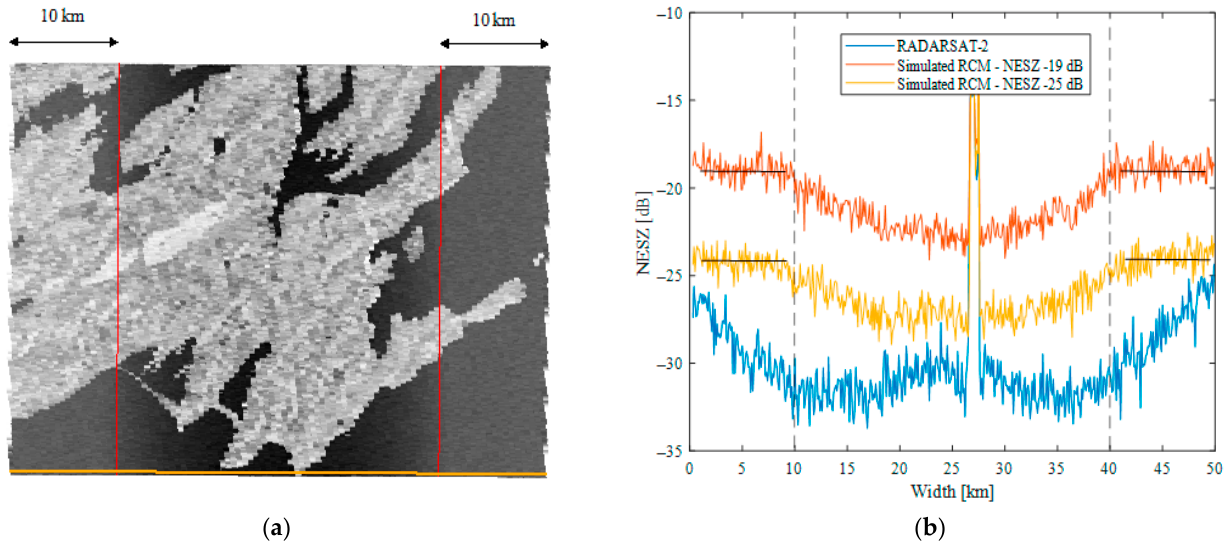
Figure 4. ( a ) Left: the initial extent of the simulated RCM data in the HV polarization, generated from the original RADARSAT-2 FQ17W mode over the Bay of Quinte, where red vertical lines show the 10 km strips at each side of the image where the simulated noise floor is not realistic. ( b ) Right: the noise pattern in RADARSAT-2 and simulated RCM medium and high-resolution mode data across the image (the area where values were extracted from is shown in ( a ) as an orange line plotted across the water at the bottom of the map). Note that the peak in the middle of the plot is where the orange line intersects with land.